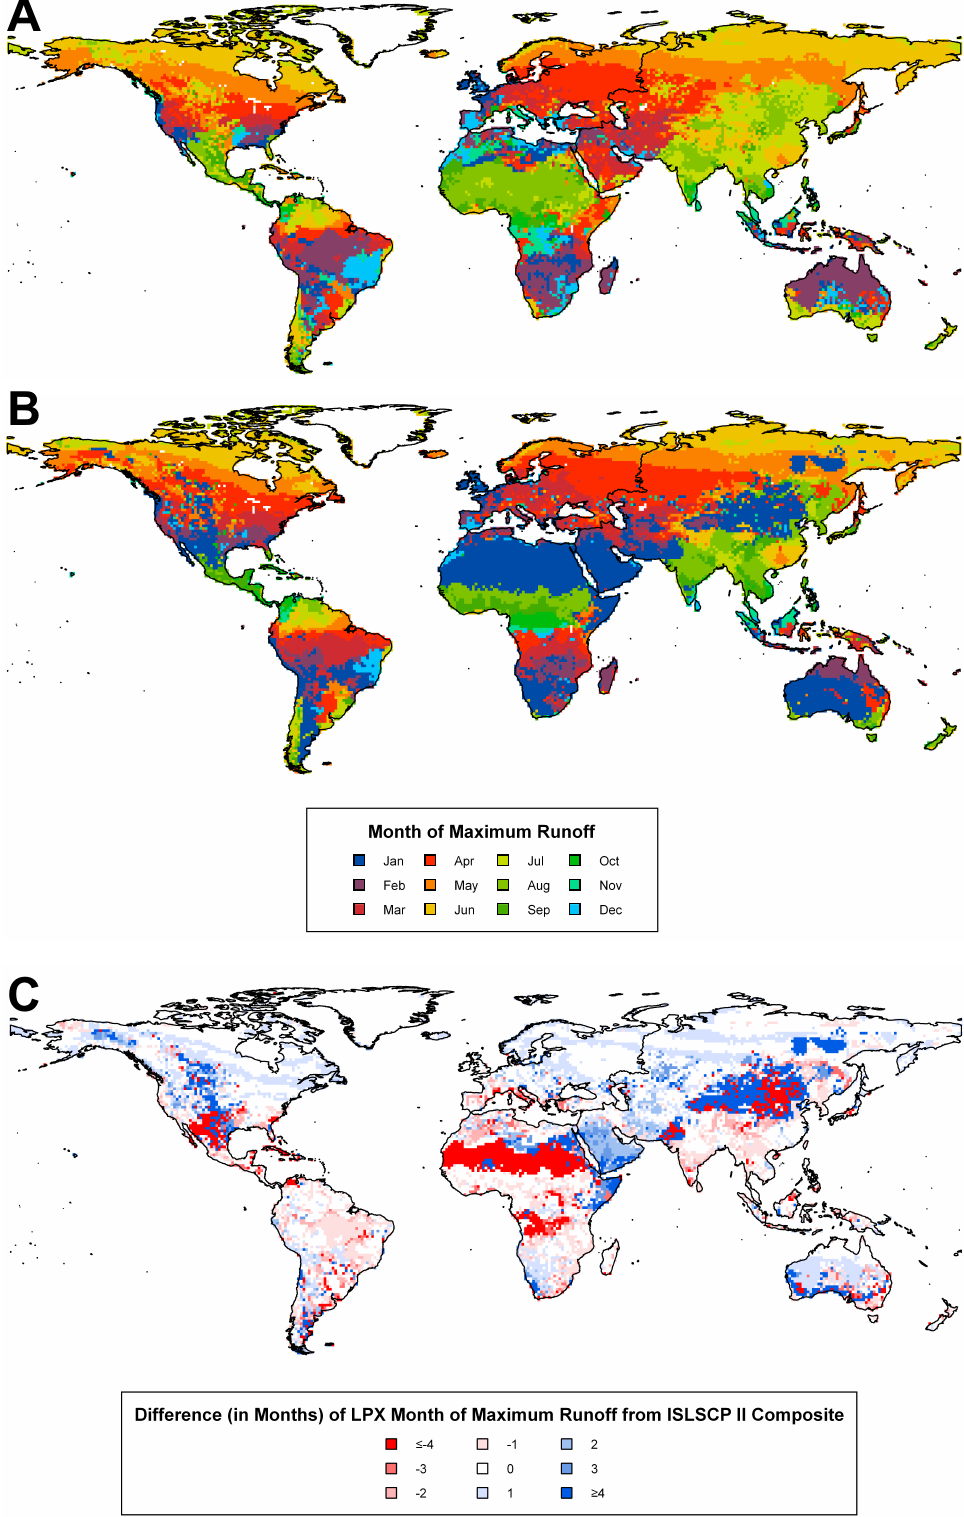
Fig. 9. (A) – Month of maximum runoff as simulated by LPX. (B) – Month of maximum runoff for as represented by the ISLSCP II composite dataset. (C) – Difference in months between month of maximum runoff of LPX from the ISLSCP II composite dataset.